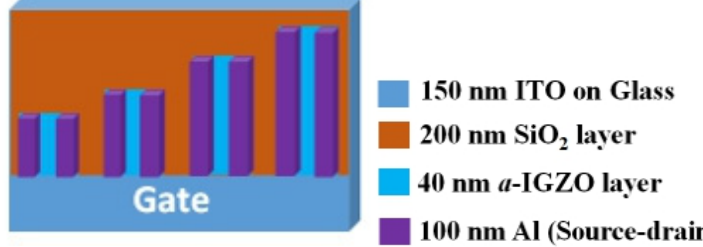
Figure 1. Schematic illustration of the device structure of amorphous indium gallium zinc oxide ( a -IGZO) thin-film transistor (TFT) fabricated on a glass substrate.